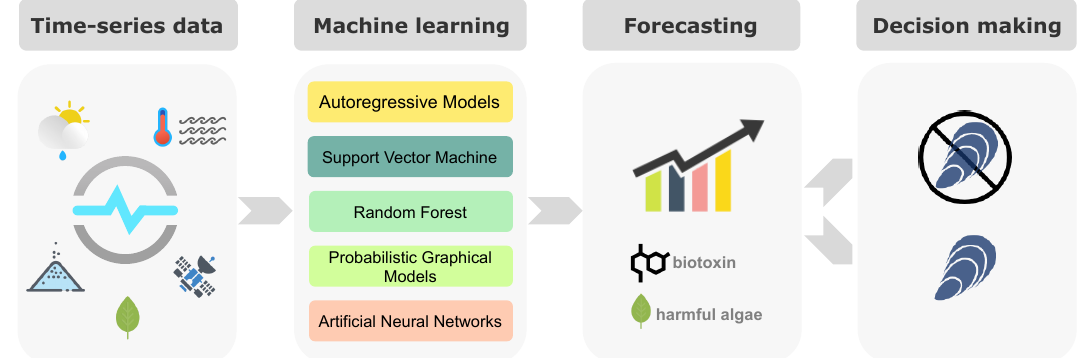
Figure 1. Schematic representation of a conceptual machine learning-based system to forecast shellfish contamination and support the decision making